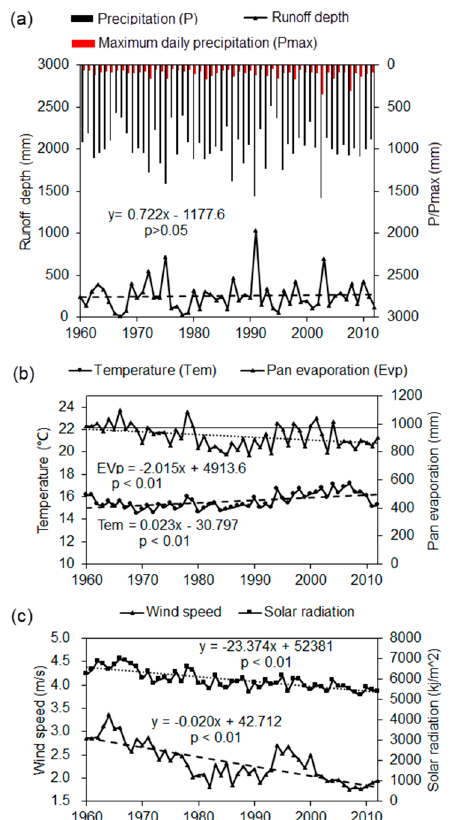
Figure 2. The inter-annual change of hydro-meteorological variables (( a ) precipitation, maximum daily precipitation, and runoff depth; ( b ) temperature and pan evaporation; and ( c ) wind speed and solar radiation) between 1960 and 2012 for the Qingliu River basin.